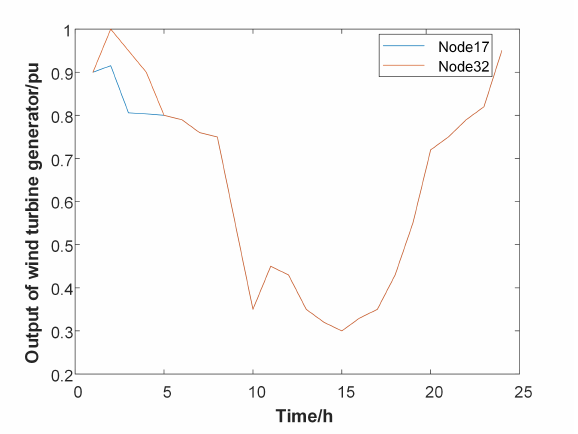
Fig. 3. Output of wind turbine